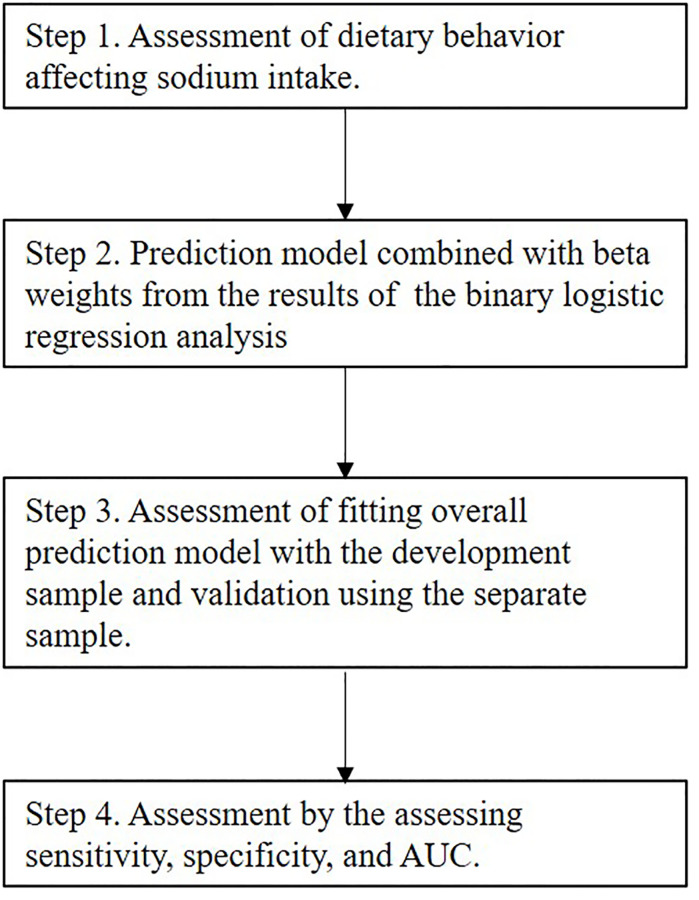
An overview of the analysis steps applied for this study.AUC, areas under receiver operating characteristic curve.